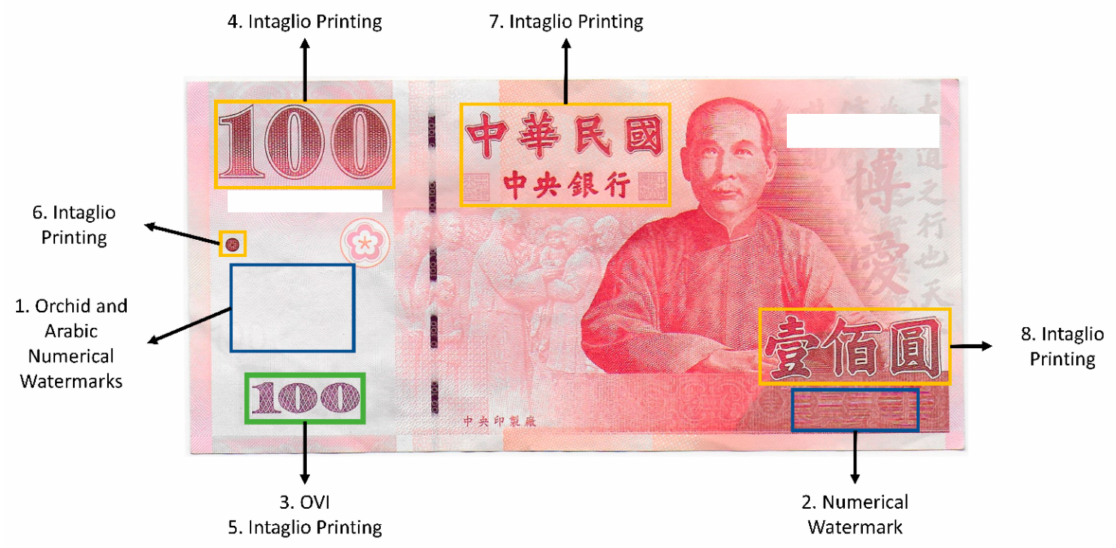
Figure 1. Security features of the 100 NTD